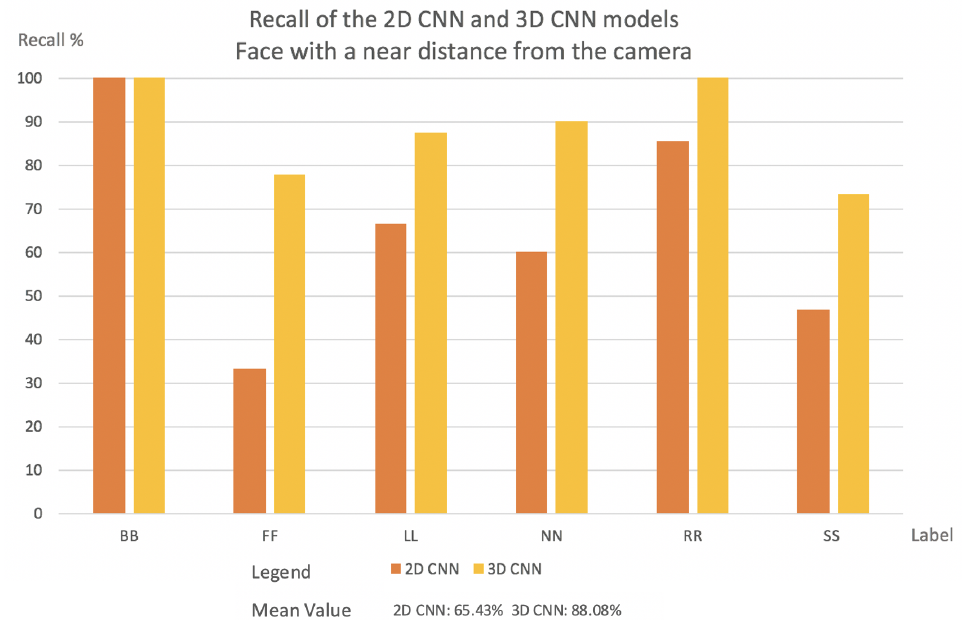
Figure 8. The percentage of labels successfully classified by the network in both models for videos facing the camera at a near distance.